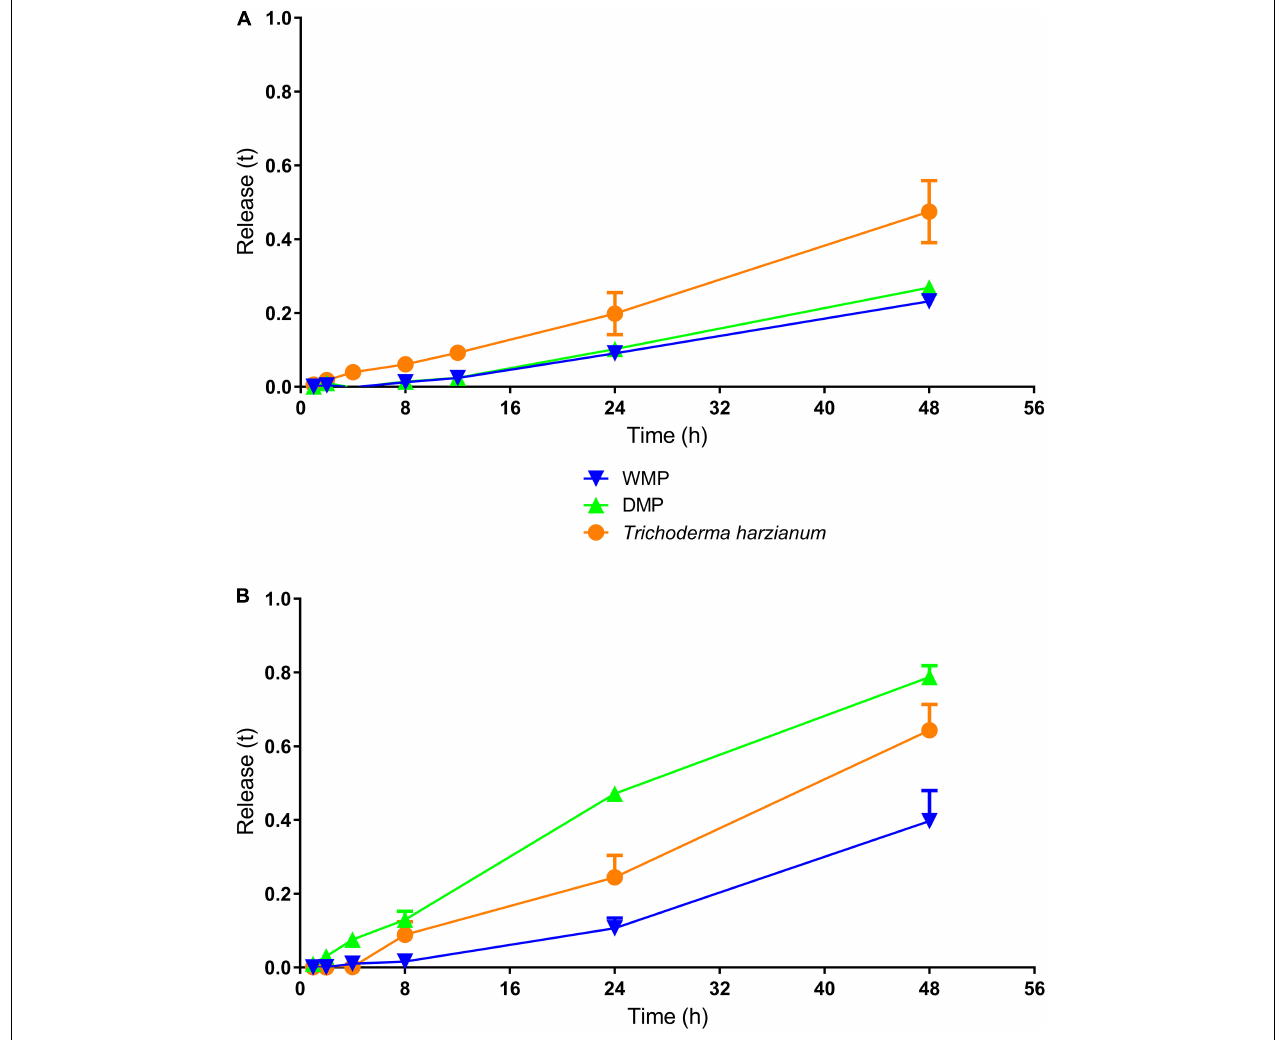
FIGURE 5 | The release kinetics assays using the wet and dry microparticles with encapsulated T. harzianum , as well as the unencapsulated fungus, without (A) or with (B) exposure to ultraviolet radiation. The encapsulated fungus presented slower